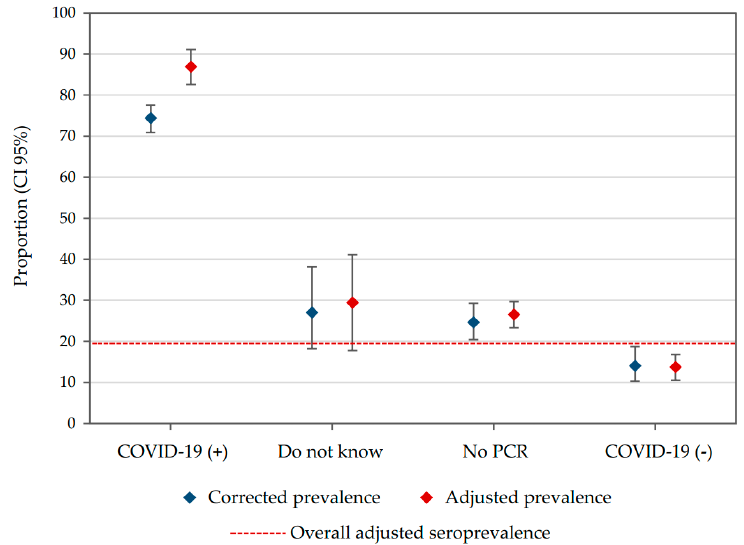
Figure 5. Seroprevalence according to self-reported COVID-19 previous diagnosis. Dashed line represents the overall adjusted seroprevalence estimated in our study. This line was added for comparison purposes.